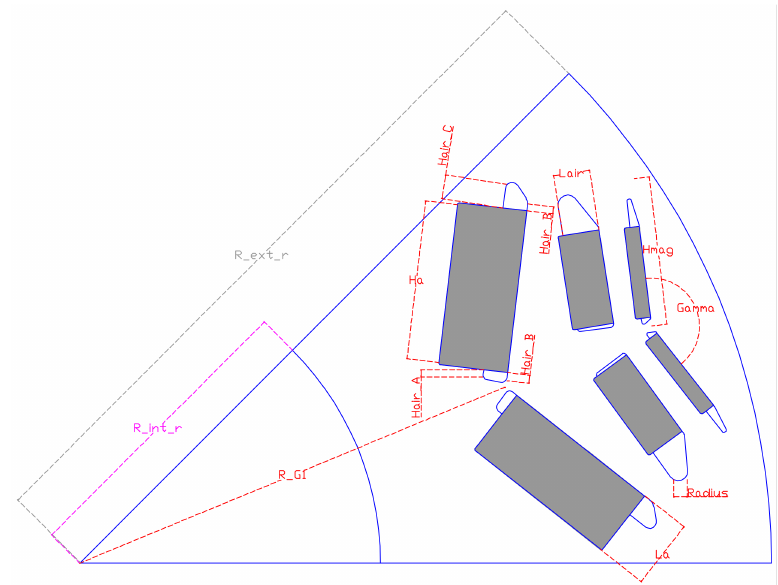
Figure 4. Rotor geometry